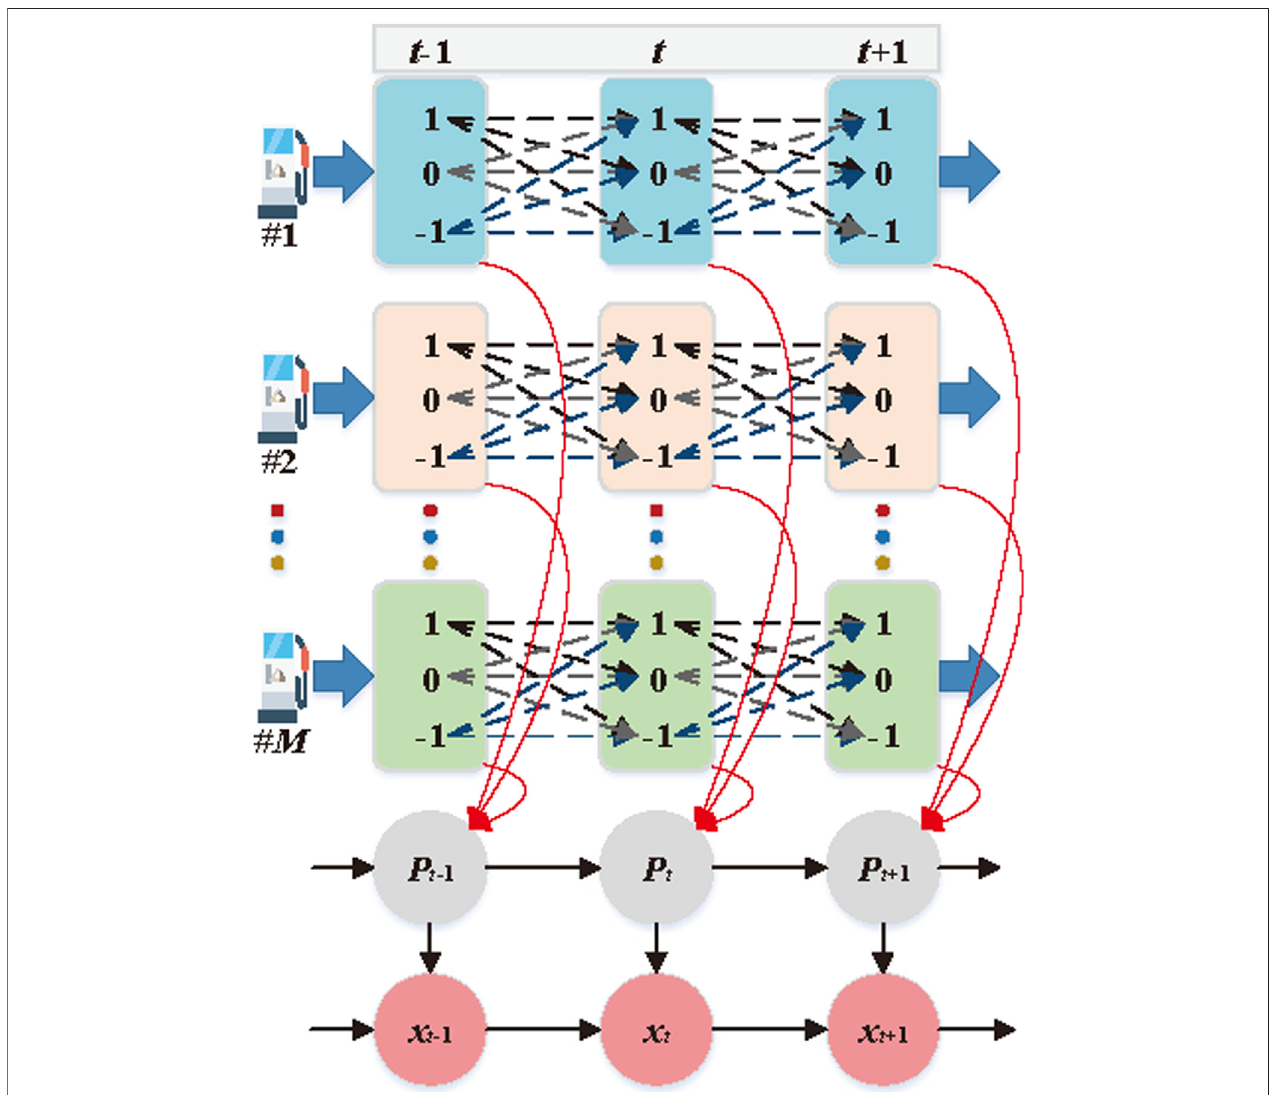
FIGURE 3 | Framework of nonintrusive monitoring for the EV